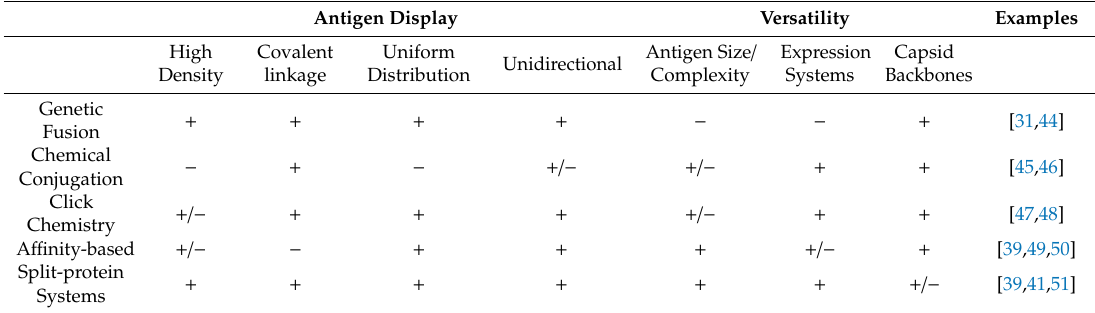
Table1. Propertiesofdi ff